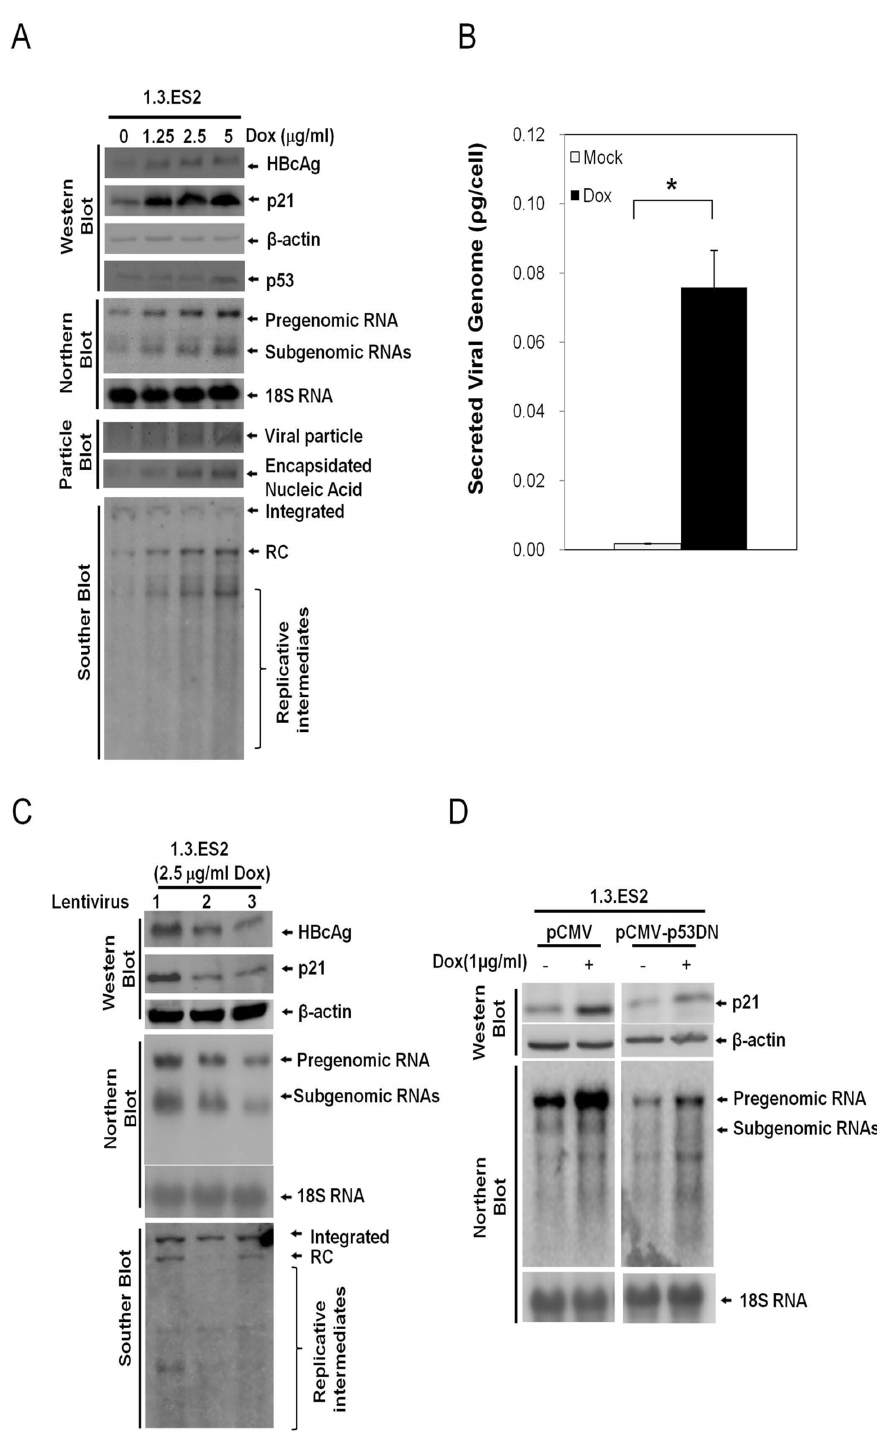
Fig 1. Doxorubicin modulates the expression levels of HBV, p21, and p53 in 1.3.ES2 cells. (A) The effect of doxorubicin treatment on HBV replication. 1.3.ES2 cells were treated with different doses of doxorubicin for 1 hour, and then their culture medium was replaced with fresh culture medium. Total DNA, total RNA and cell lysates were obtained three days after doxorubicin treatment for 1 hour for Southern blot, Northern blot and particle blot/Western blot analyses, respectively. The expression levels of HBV transcripts, viral particles, HBcAg, p21, and p53 are shown. (B) The effect of doxorubicin on the modulation of